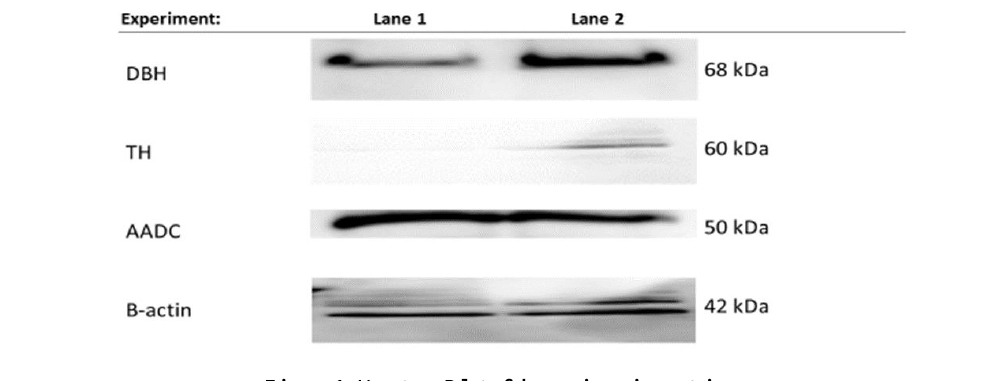
Figure 1: Western Blot of dopaminergic proteins.